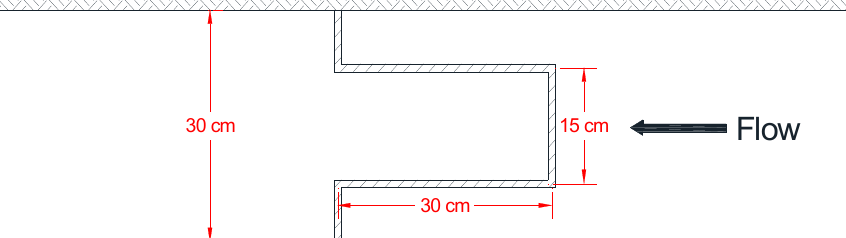
Figure 4. Schematic diagram of flow over rectangular labyrinth weir including flow parameters. H T is defined as: